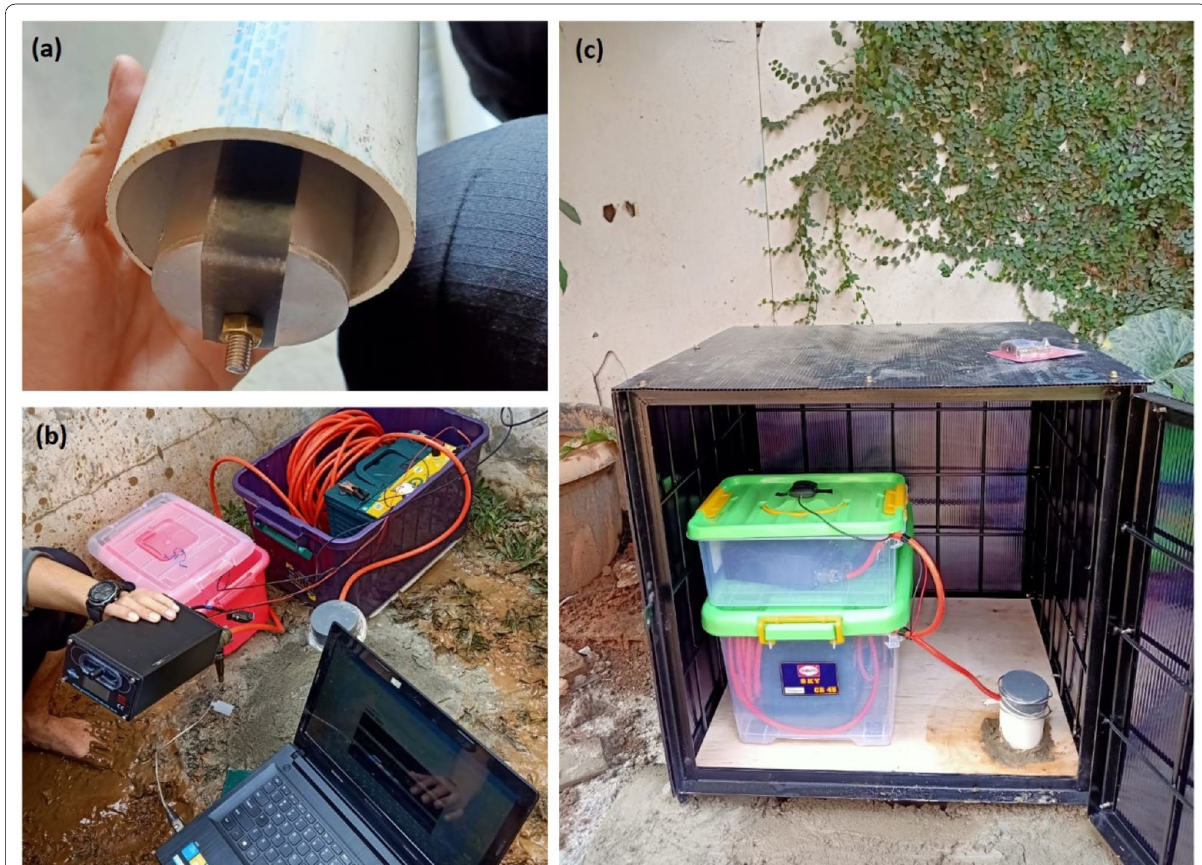
Fig. 2 Photographs of instrumentation and example field sites. a C100 wideband seismometer, b Sri32L Geobit digitizer, and c borehole instrumentation at BAR6 in